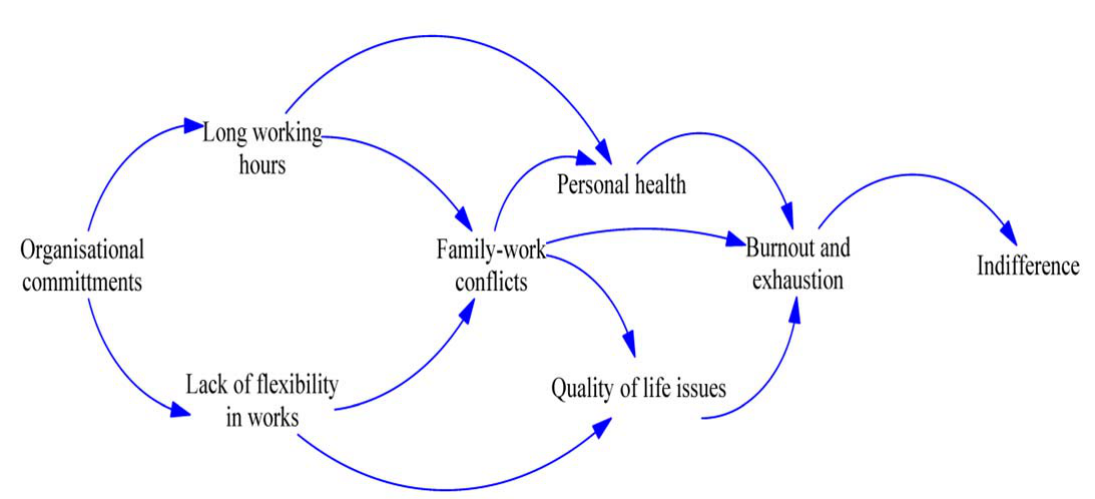
Figure 1: Main problems associated with job satisfaction in the South Australian construction industry (source: